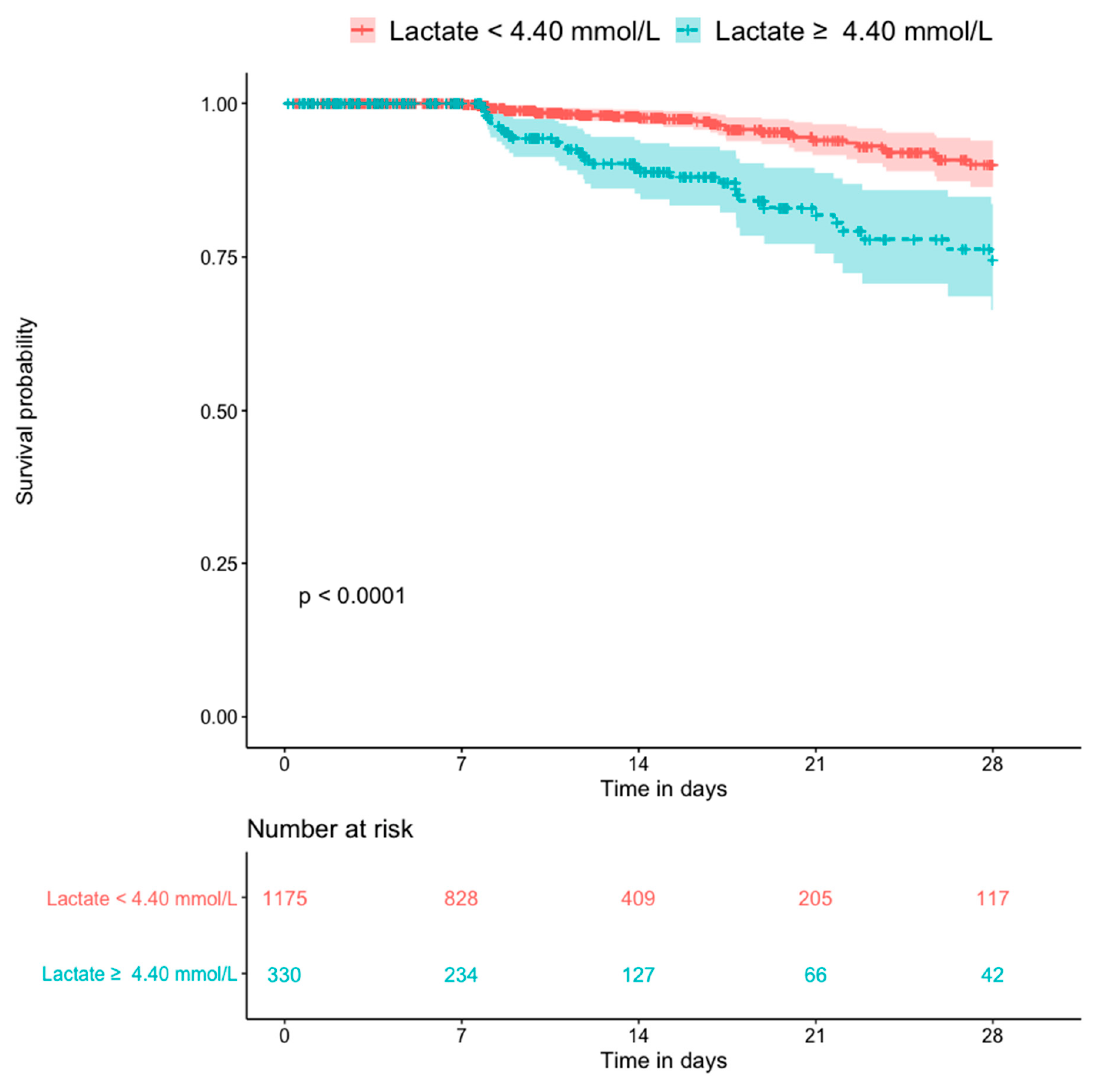
Figure 5. Kaplan–Meier plot for 28-day death compared by the lactate level (n = 1505).